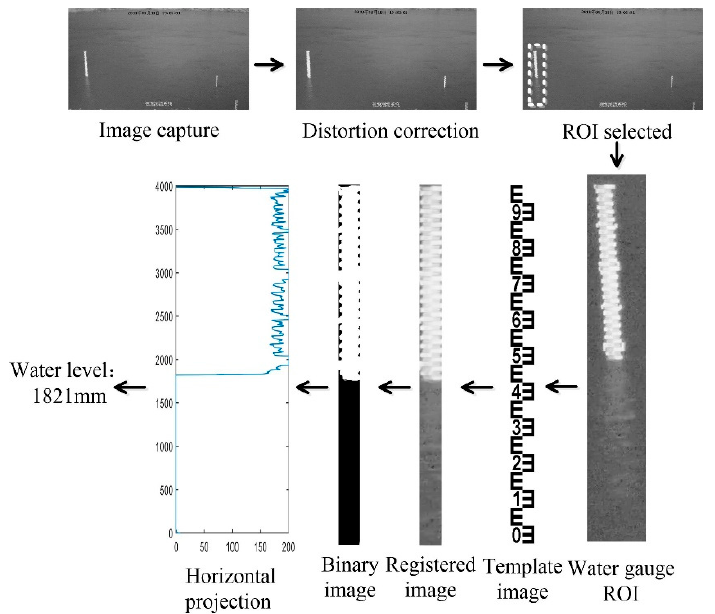
Figure 4. Principle of water-level measurement. (ROI, region of interest).